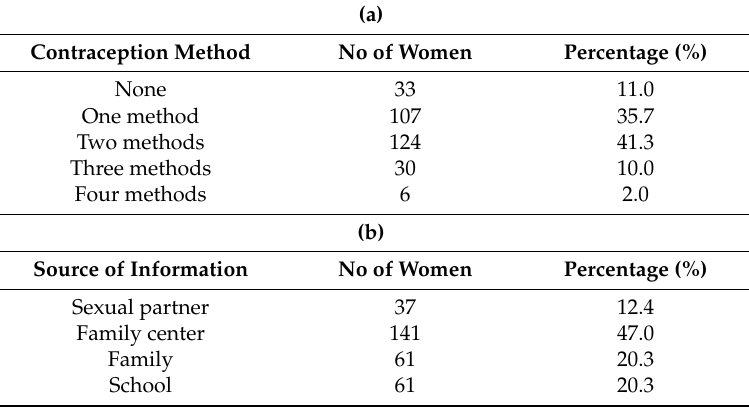
Table 3. ( a ) Different methods of contraception in the study population; ( b ) Source of information regarding